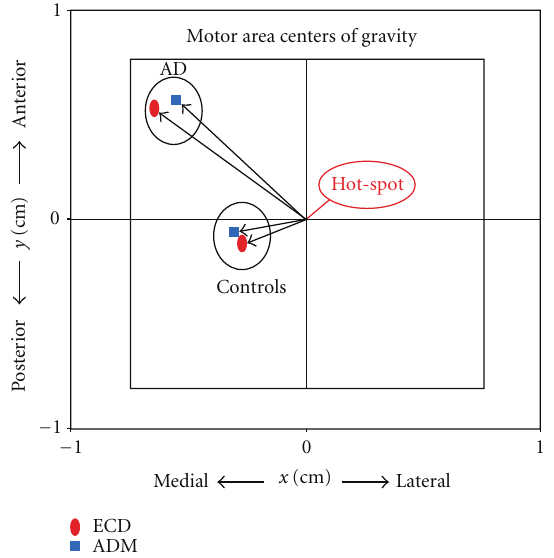
Figure 3: AD: Alzheimer disease, ADM: Abductor Digiti Minimi Muscle, ECD: Extensor Digitorum Communis Muscle, Hot-Spot: scalp site of maximal excitability. This picture shows that the coordinates of the map center of gravity compared to the hot- spot appear on average significantly di ff erent in the two groups: in controls the center of gravity matches with the hot spot and is located in the center of the map. In patients there is a marked frontal and medial shift of center of gravity compared to Hot-Spot. (modified from